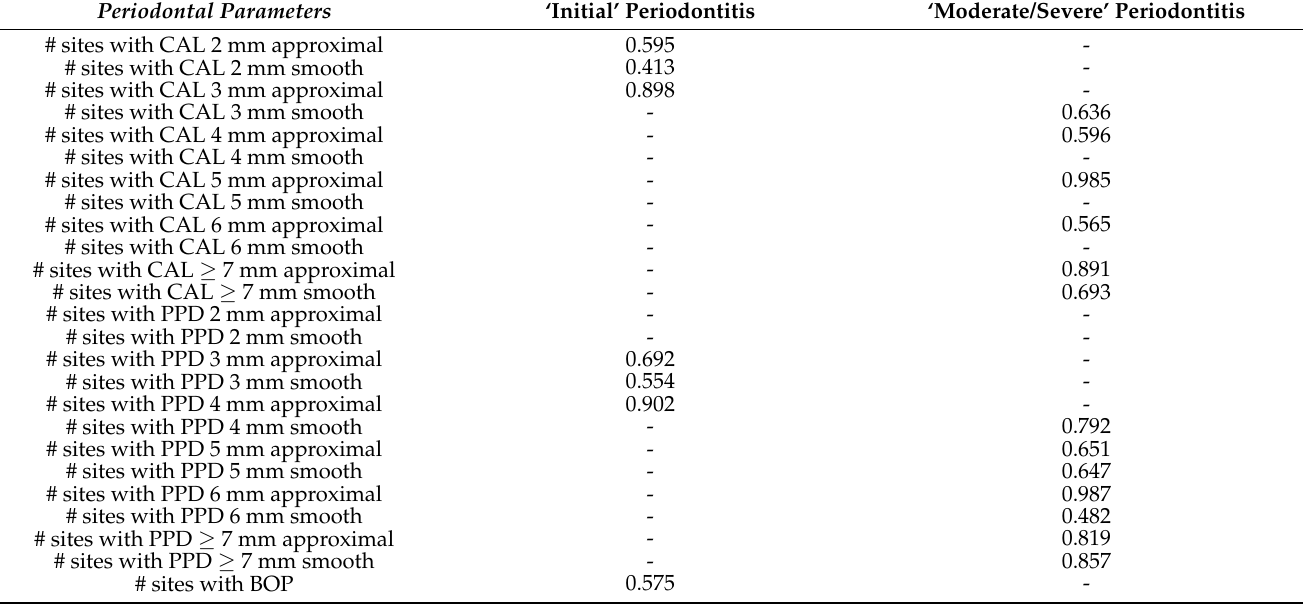
Table A1. Results from the exploratory factor analysis given as the factor structure with the respective factor loadings.